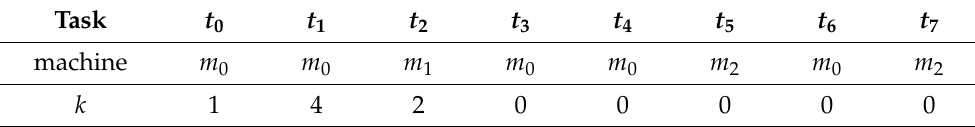
Table 3. Configuration machine/voltage.